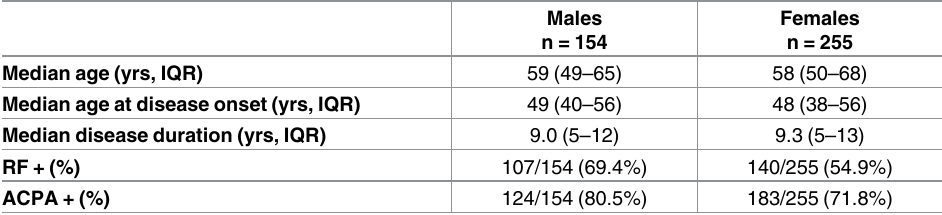
Table 2. Cohort 2 demographic